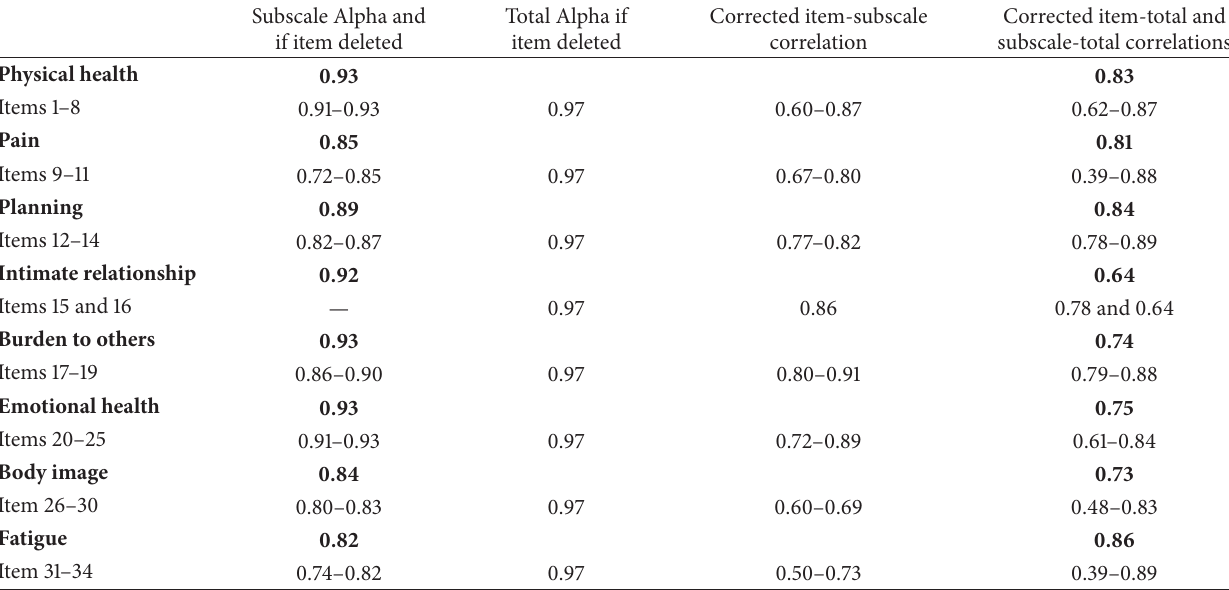
Table 2: Cronbach’s alpha for the total scale and its subscales’ and item analysis.